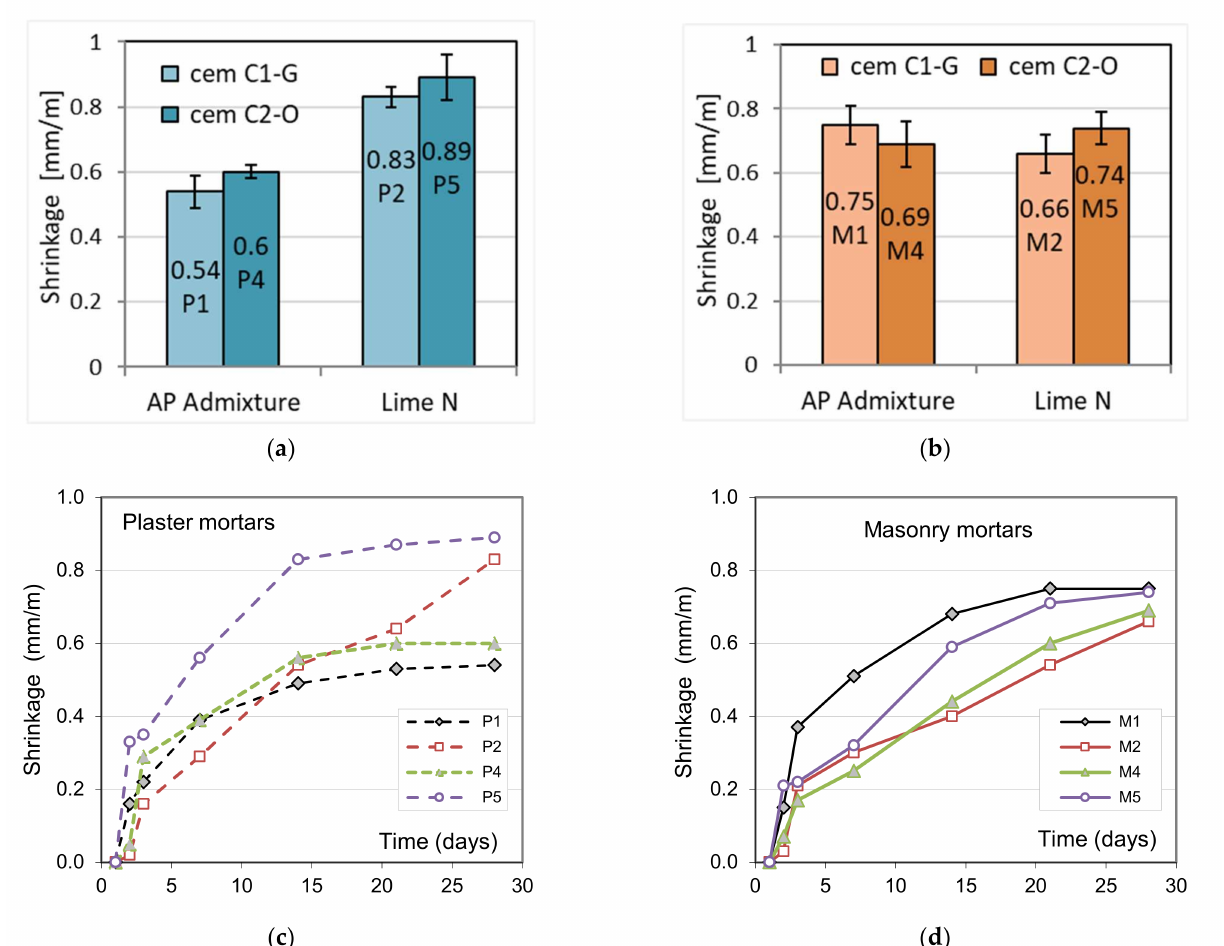
Figure 9. Shrinkage of plasters ( a , c ) and masonry mortars ( b , d